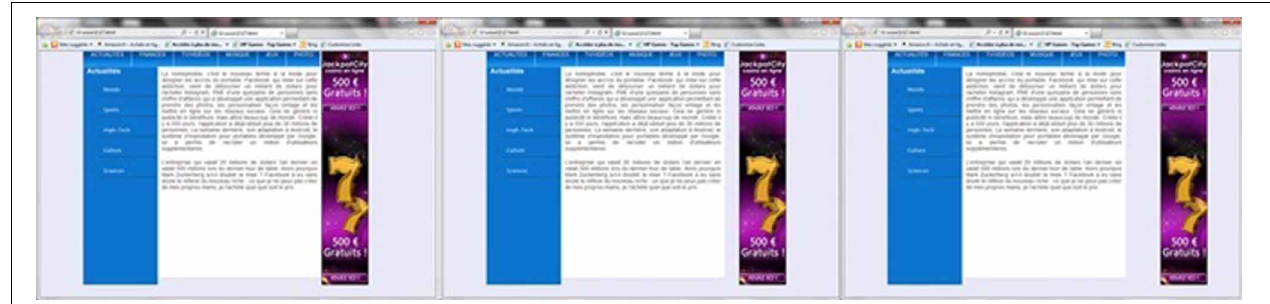
FIGURE 1 | Examples of Web pages in the three Distance conditions (near, 0px; intermediate, 40px and far, 80px).